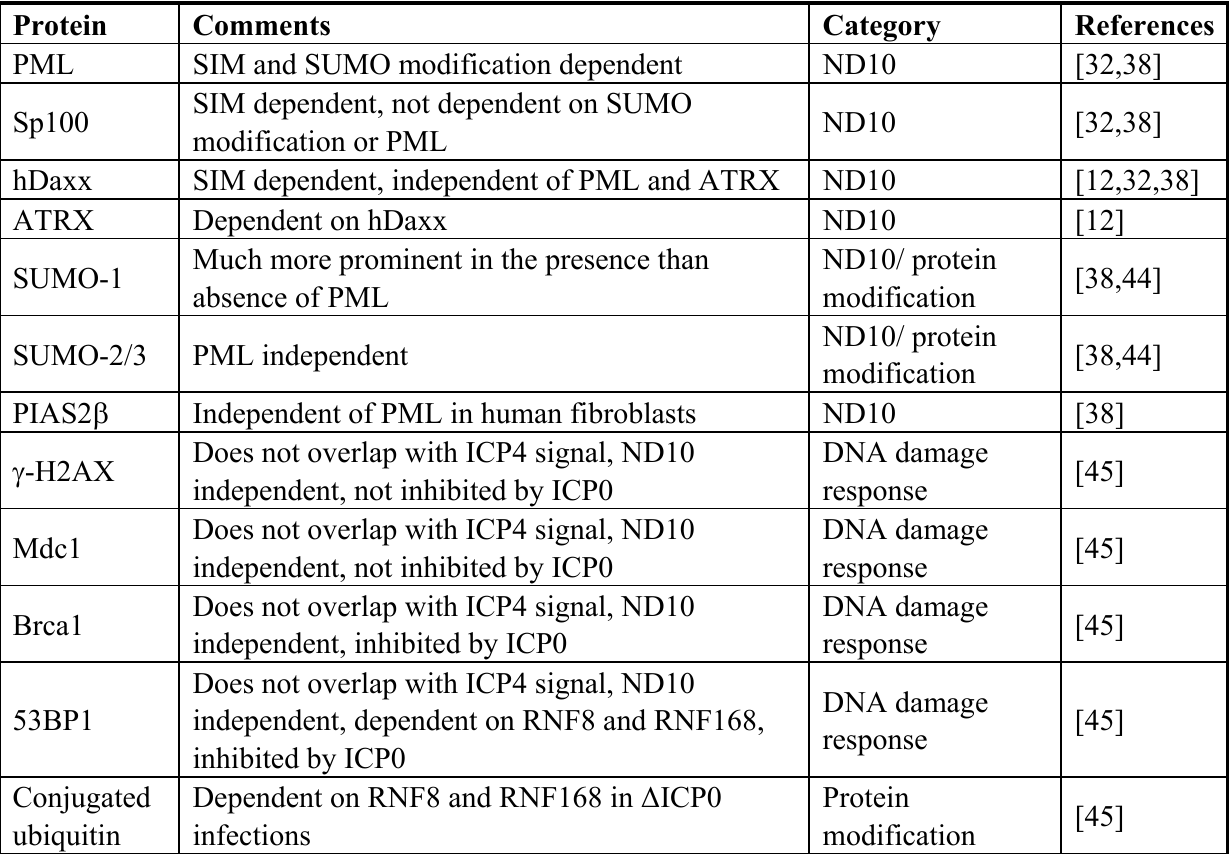
Table 1. Cellular proteins recruited to HSV-1 associated